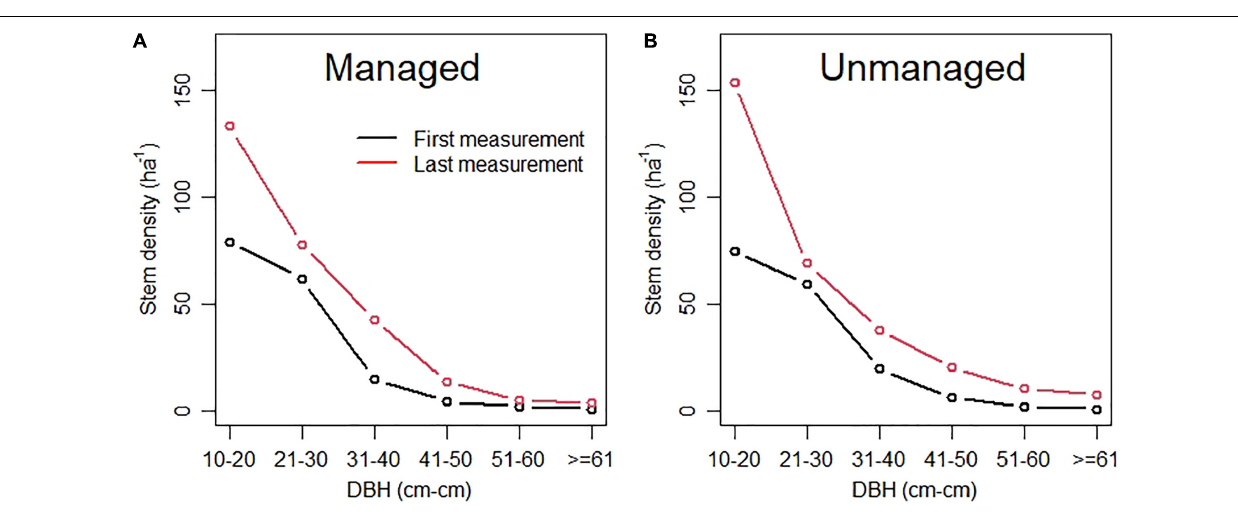
FIGURE 7 | Diameter distribution of managed (A) and unmanaged (B) plots. The lower black line shows the conditions at first measurement, the upper red line at the last measurements about five decades